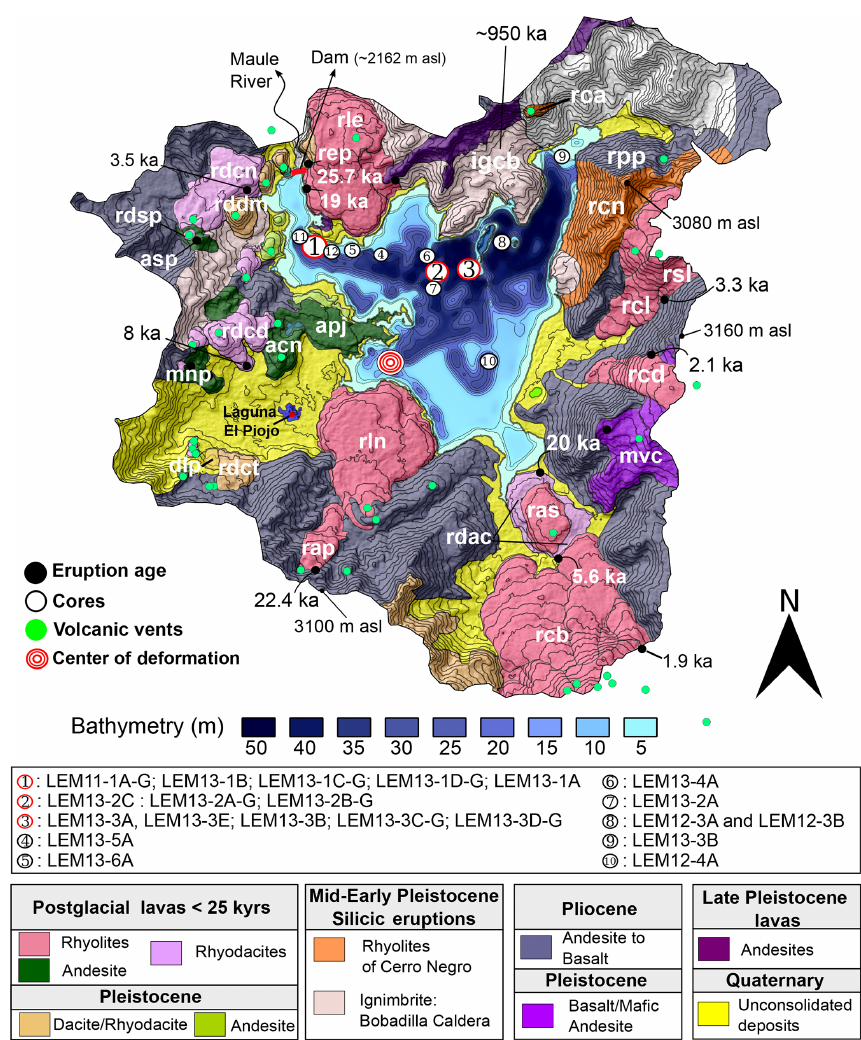
Figure 2. Bathymetric and geological map of LdM volcanic complex (based on Hildreth et al., 2010; Andersen et al., 2017; Singer et al., 2018). White, green, gray and red circles indicate coring sites, volcanic vents and sample locations for 40 Ar , 39 Ar and 36 Cl dating (Andersen et al., 2017) and El Piojo lake, respectively. The cores used to determine the reservoir effect correction are derived from site 3 (LEM13-3D-G: 14 C age for the wood) and site 12 (LEM11-3A-G: 14 C age for macrophytes). Gray circles showing eruptions ( > 25kyr) composed principally of the ignimbrite of Cajones de Bobadilla (igcb; ∼ 950kyr), rhyolite of Cerro Negro (rcn; ∼ 447kyr), rhyodacite of Domo del Maule (rddm; ∼ 114kyr), basalt of El Candado (bec; ∼ 63kyr) and the andesite of Arroyo Los Mellicos (aam; ∼ 26kyr). Eruptions ( < 25kyr) include the rhyolite east of Presa Laguna del Maule (rep; 25.7kyr), rhyolite of Loma de Los Espejos (rle; ∼ 19kyr), rhyolite of Cari Launa (rcl; < 3 . 3kyr), rhyolite south of Laguna Cari Launa (rsl; 3 . 3 ± 1 . 2kyr), rhyolite of Arroyo de Sepúlveda (ras; 20–19kyr), rhyolite of Cerro Barrancas (rcb; multiple flows 11.4–1.9kyr), rhyolite of Colada Divisoria (rcd; 2 . 1 ± 1 . 3kyr), rhyolite of Colada Las Nieblas (rln; Late Holocene), rhyodacite of Arroyo de la Calle (rdac; ∼ 20 ± 1 . 2kyr), rhyodacite of Colada Dendriforme (rdcd; 8 ± 0 . 8kyr), rhyodacite of the northwest coulee (rdcn; 3 . 5 ± 2 . 3kyr), rhyodacite of Laguna Sin Puerto (rdsp; < 3 . 5kyr), rhyodacite west of Presa Laguna del Maule (rdop), andesite of Laguna Sin Puerto (asp; < 3 . 5kyr) and the younger andesite of the west peninsula (apj; 21 ± 3 . 4kyr). The age uncertainties are 2 σ